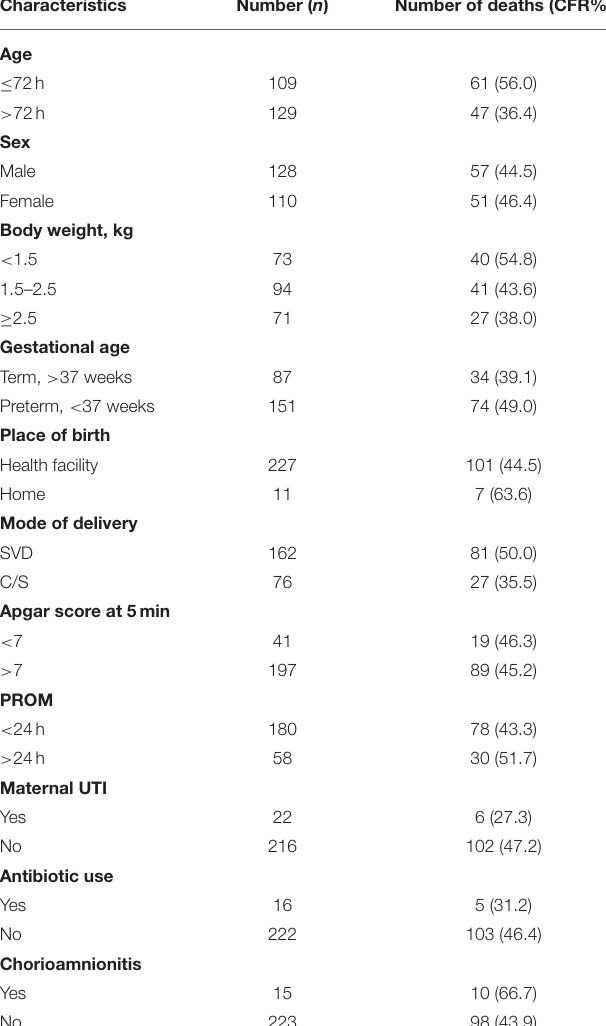
TABLE 1 | Distribution of case fatality rate (CFR) of 238 study neonates with culture-proven sepsis based on infant and maternal factors.